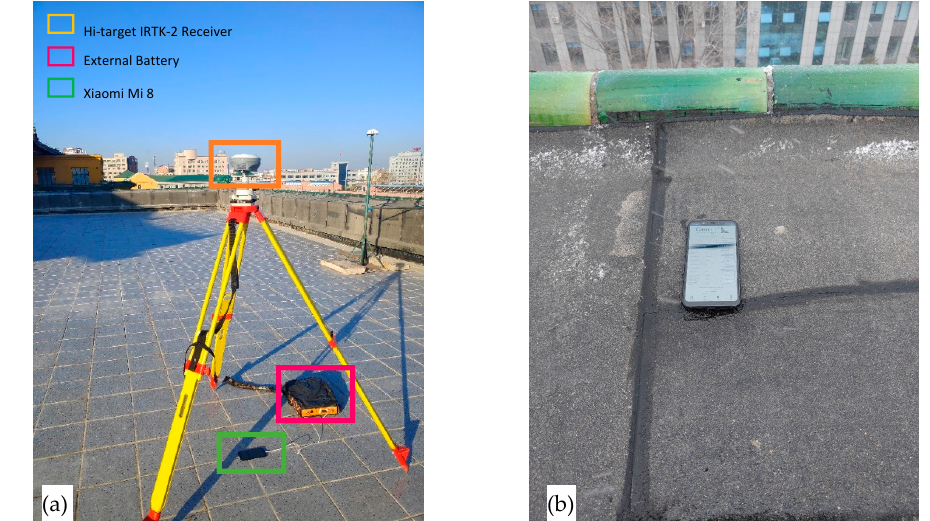
Figure 2. View of data collection at roof of Geological Palace Museum (( a ) under the GNSS antenna; ( b ) on the edge of the roof).